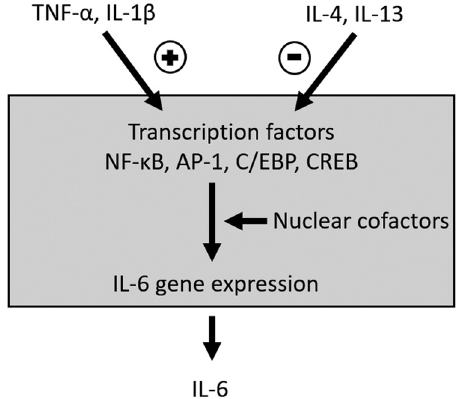
Figure 3: IL - 6 is an in fl ammatory cytokine produced by several cell types, both lymphoid and non - lymphoid, most notably T - lympho - cytes, macrophages, and fi broblast upon stimulation by TNF - α and IL -